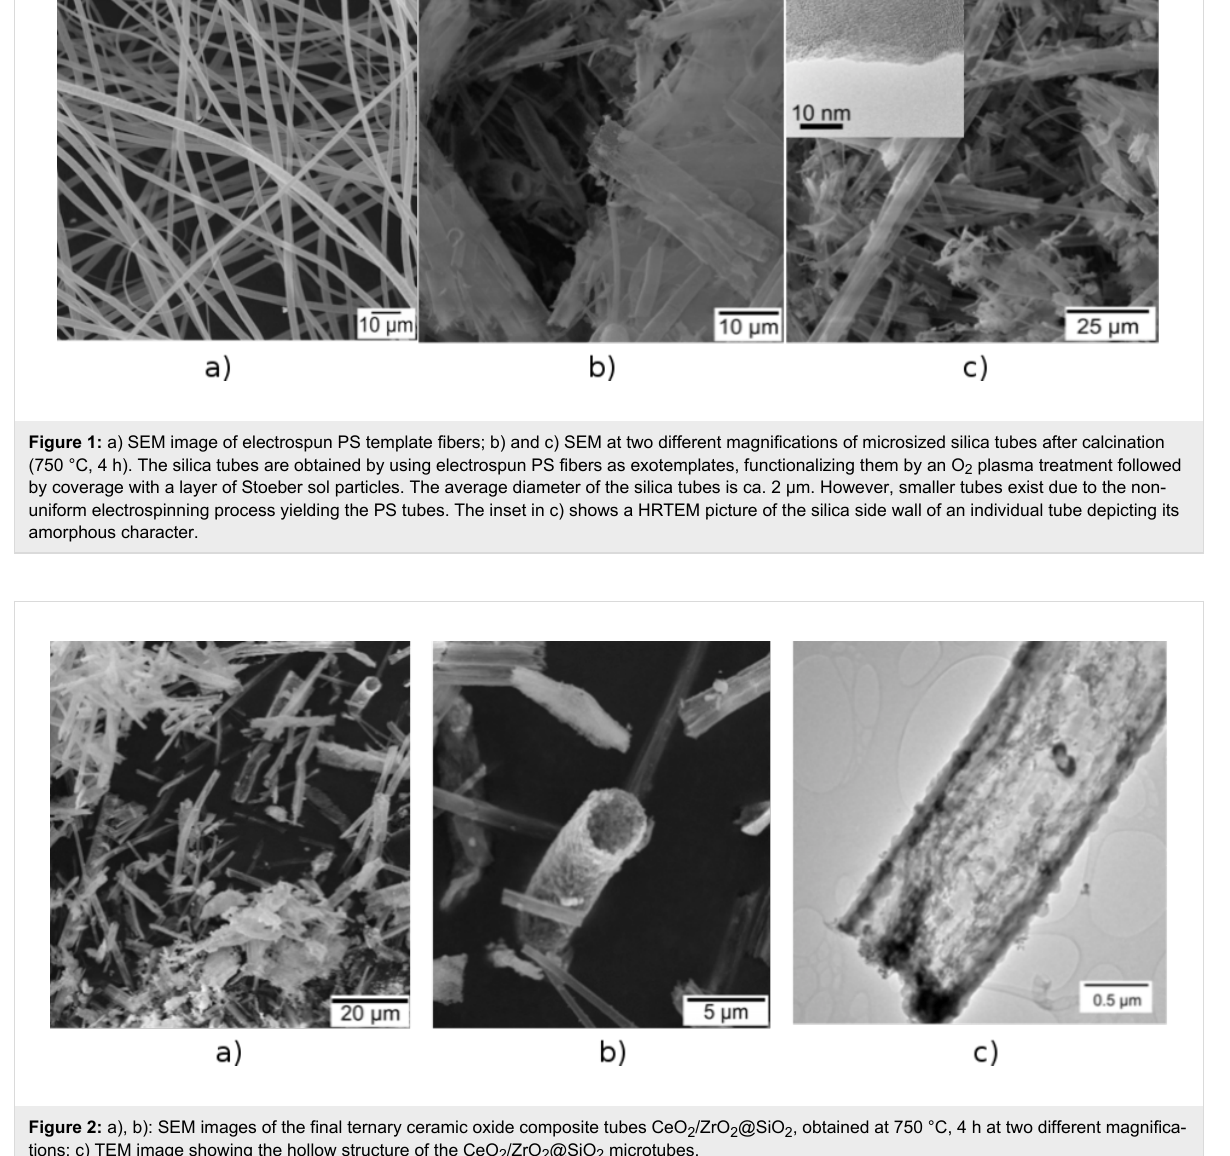
Figure 2: a), b): SEM images of the final ternary ceramic oxide composite tubes CeO 2 /ZrO 2 @SiO 2 , obtained at 750 °C, 4 h at two different magnifica- tions; c) TEM image showing the hollow structure of the CeO 2 /ZrO 2 @SiO 2